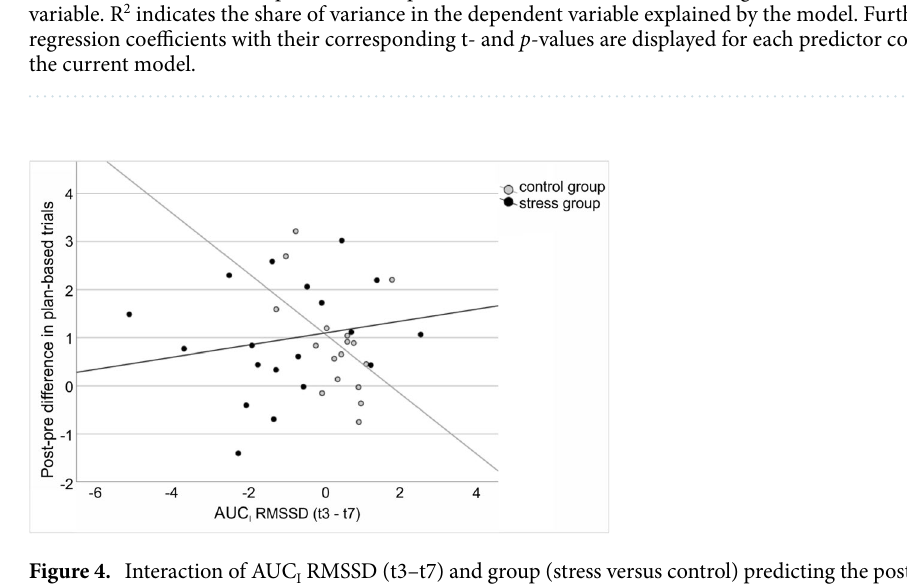
adrenal (hpa) axis (via cortisol) and of the autonomic nervous system (ANS, via HRV and HR). Thus, we were able to generate an impression of the association of each of these systems with movement selection performance under stress and control. A regression model predicting performance change in plan-based movement selection from the factor group (stress versus control), its interaction with stress-induced changes in cortisol, HR and RMSSD and the control variables BMI and age was significant and explained 51.8% of variance. The predictors HR, RMSSD as well as the interaction of group with RMSSD contributed significantly to the model. This finding points towards the modulation capability of the plan-based approach to movement selection that seems to be primarily driven by changes in the ANS, reflected by changes in HR and RMSSD in the current study. Especially